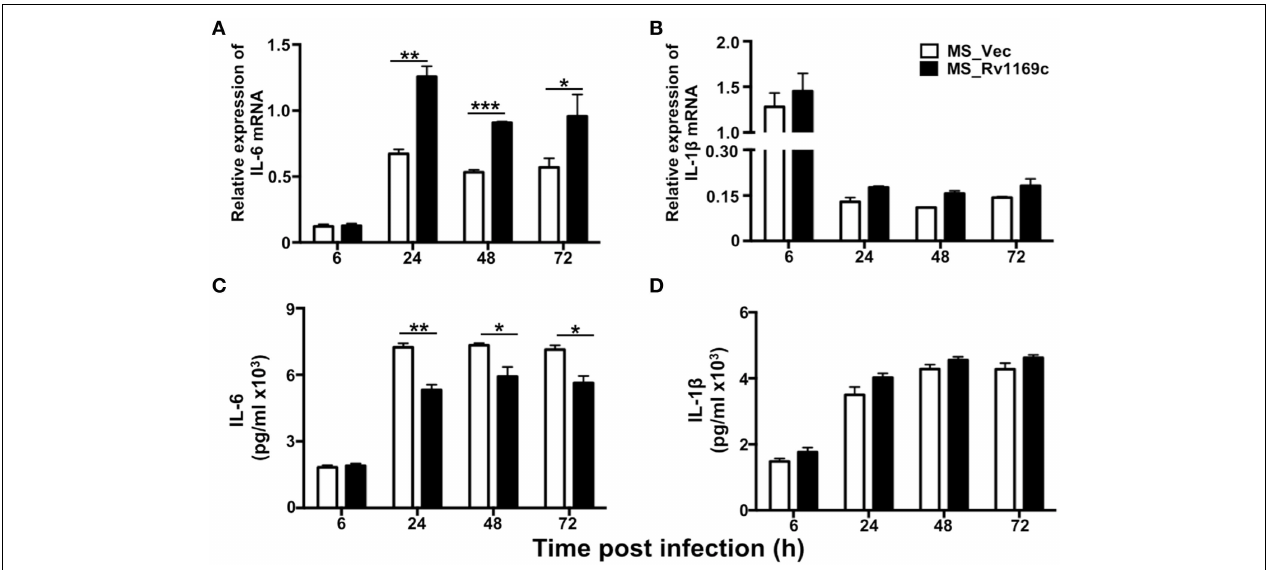
FIGURE 8 | The expression of cytokines in macrophage infected by Ms_Vec and Ms_Rv1169c. PMA-differentiated U937 macrophages ( 2 × 10 6 /well/2ml) were infected with Ms_Vec and Ms_Rv1169c strains. After 6, 24, 48, and 72h infection, the infected macrophage were